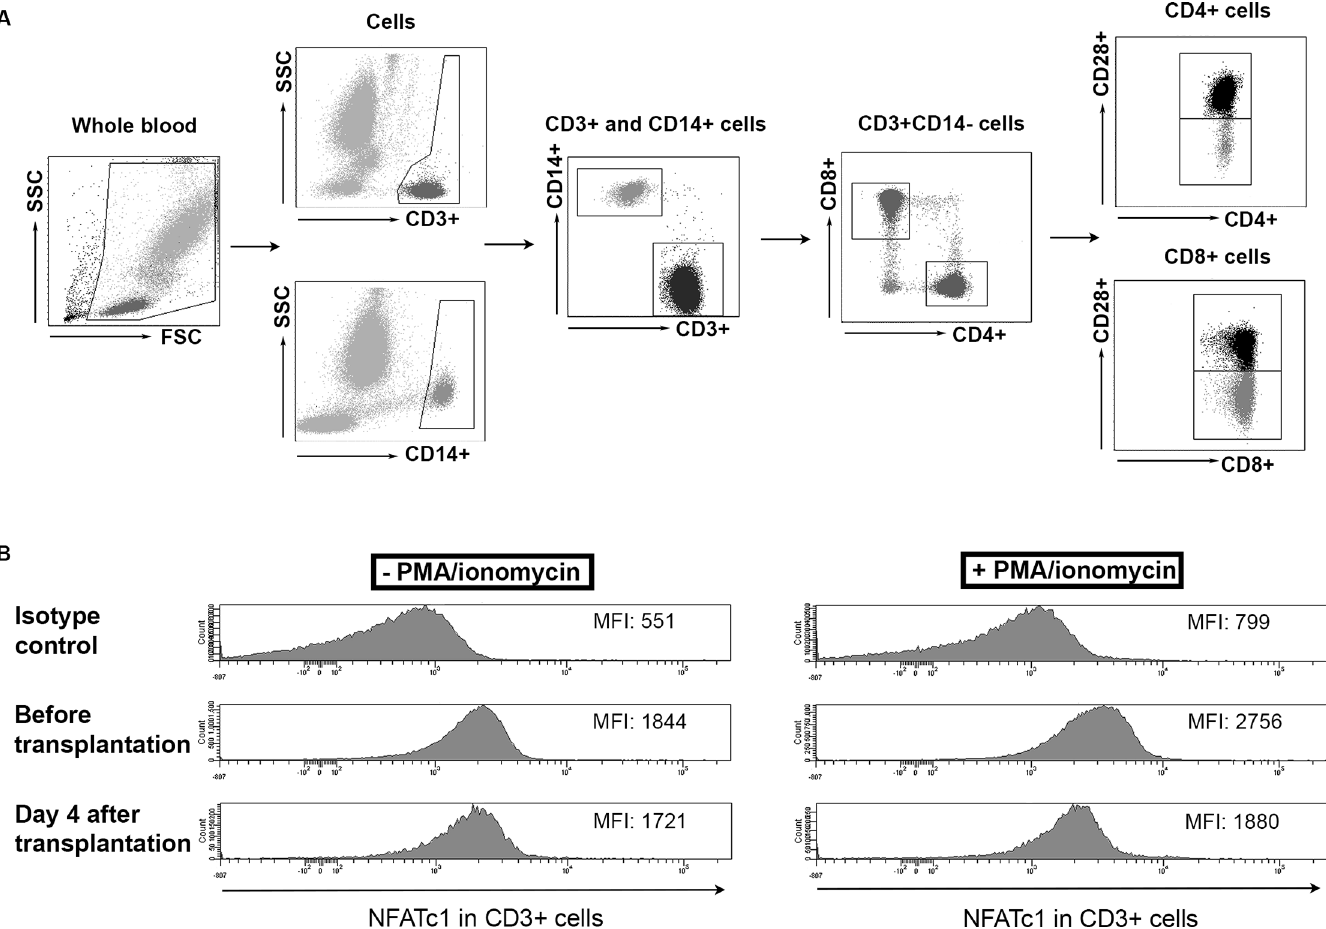
Fig 2. Gating strategy for the total NFATc1 expression in T cell subsets. (A) Gating of CD3 + T cell subsets. Cells were gated for their expression of CD14 and CD3, where after CD3 + CD14 - T cells were gated for their expression of CD4 or CD8. Within these populations, the expression of CD28 was determined to identify the CD4 + CD28 + , CD8 + CD28 + and CD8 + CD28 - T cell subsets. B) Example of the total NFATc1 expression in CD3 + CD14 - cells, either unstimulated or stimulated with PMA/ionomycin. FSC) Forward scatter; SSC) sideward